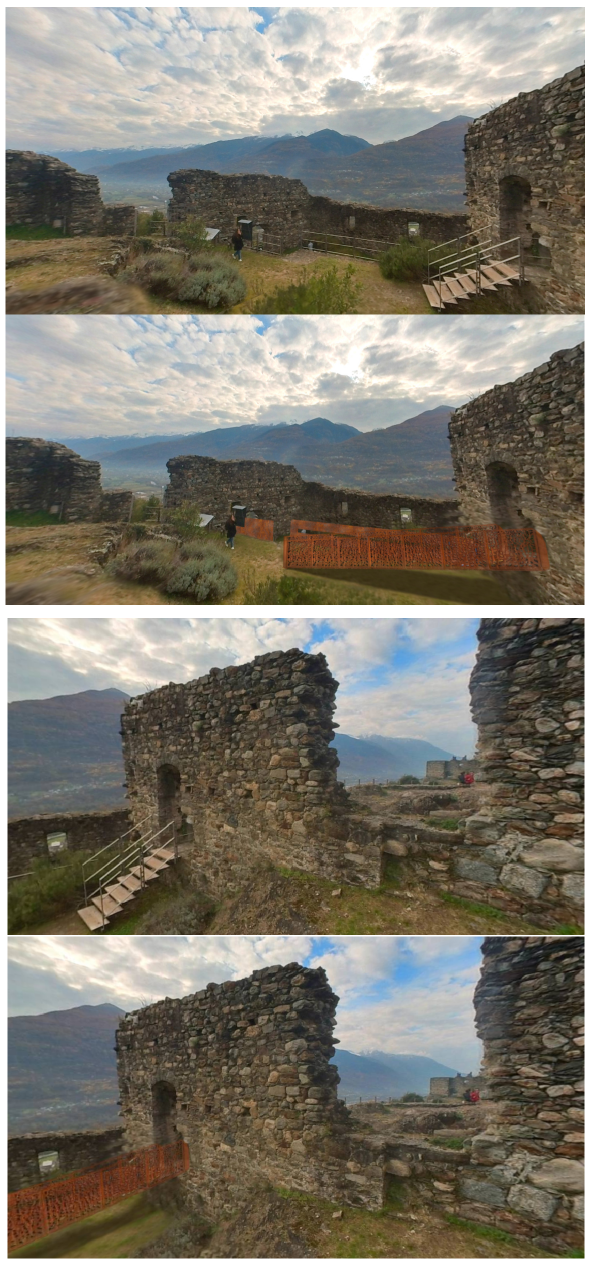
Figure 5: The equirectangular projection visualized as a cen- tral perspective with a bubble visualization, showing the original stairs (top) and the digitally added ramp